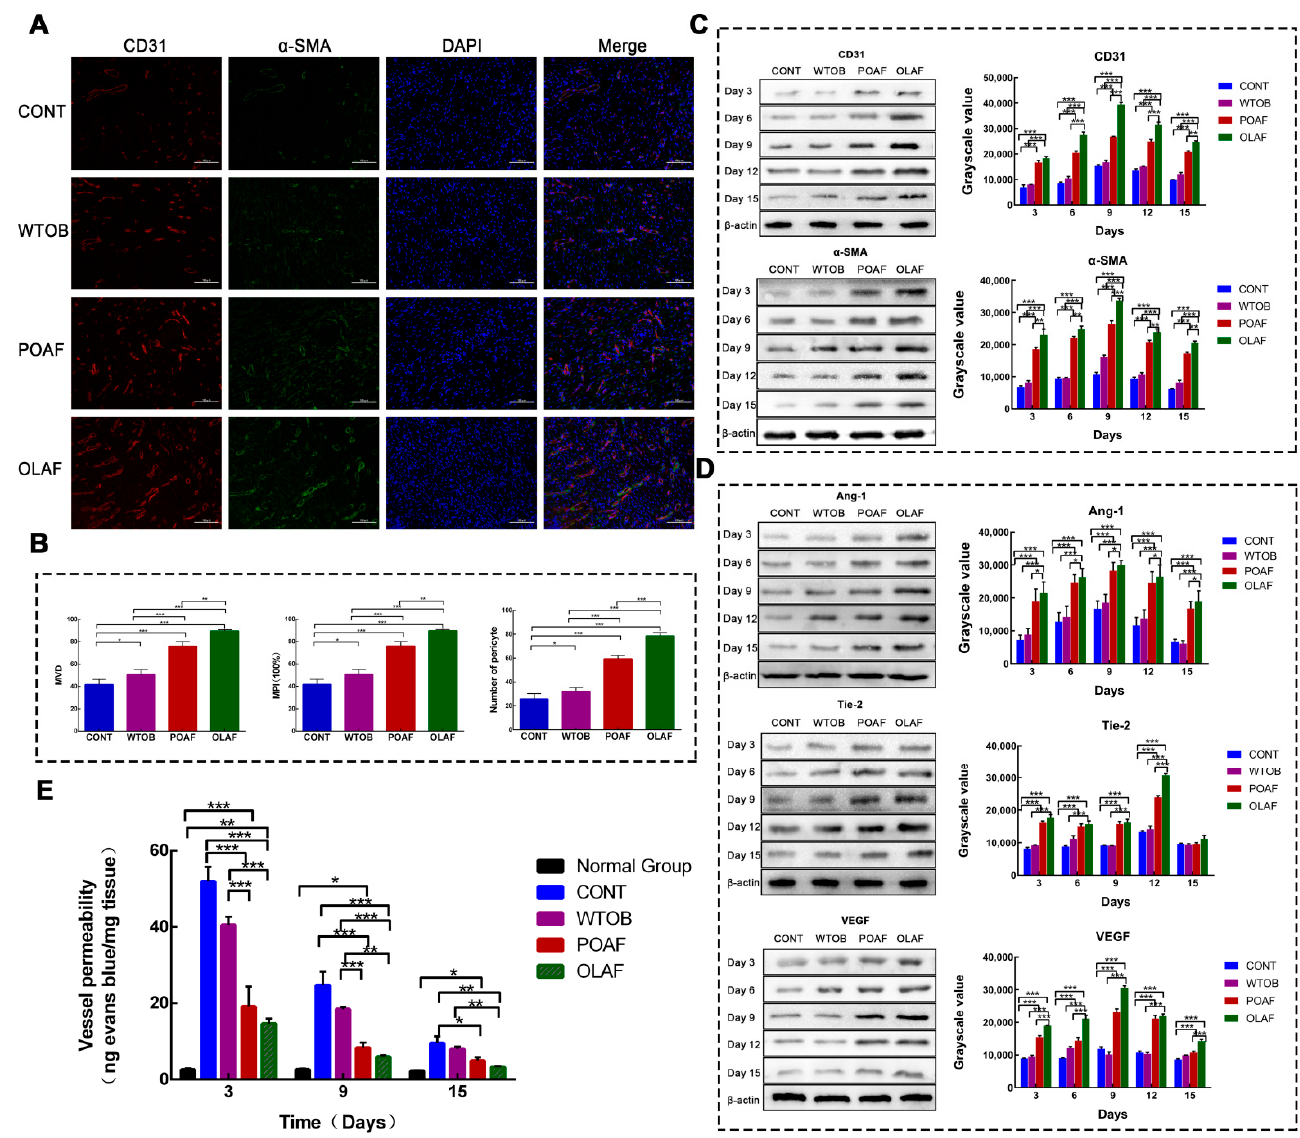
Figure 3. Evaluation of the effect of oleosomes fused with human fibroblast growth factor 1 (OLAF) on angiogenesis in rats with a full-thickness skin defect. ( A ) Representative immunofluorescence of wounds that received different substances for 9 days post-wounding for detecting CD31 (red), α -SMA (green) and DAPI (blue). Scare bar: 100 µ m. ( B ) Statistical analyses of micro-vessel density (MVD), number of pericytes and the microvascular pericyte coverage index (MPI). ( C , D ) Western blot and quantitative analyses of CD31, α -SMA and pro-angiogenic factors at different times post-injury. ( E ) Effect of OLAF on the vascular permeability in healed wounds. * p < 0.05, ** p < 0.01, *** p < 0.001. The mean ± SD was employed to display all the obtained data (n = 6).